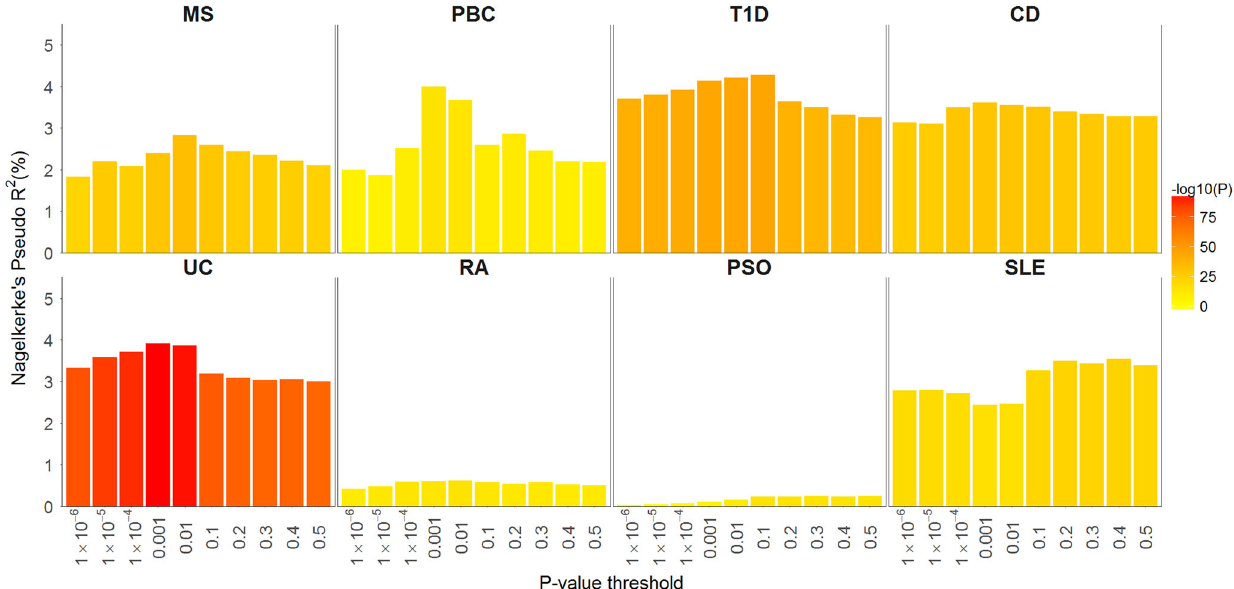
Fig. 2 The variance explained by PRS for training diseases predicting the corresponding disease in the Icelandic target cohorts. These bars show how much variance of the phenotype is explained at a given P -value threshold by the PRS calculated from the training set for the same phenotype. Celiac disease (Cel) and juvenile idiopathic arthritis (JIA) are not included in the fi gure as no Icelandic cohorts were available for these diseases. For JIA and Cel, a P -value inclusion of 0.001 was arbitrarily selected. MS multiple sclerosis; PBC primary biliary cirrhosis; T1D type 1 diabetes; CD Crohn ’ s disease; UC ulcerative colitis; RA rheumatoid arthritis; PSO psoriasis; SLE systemic lupus